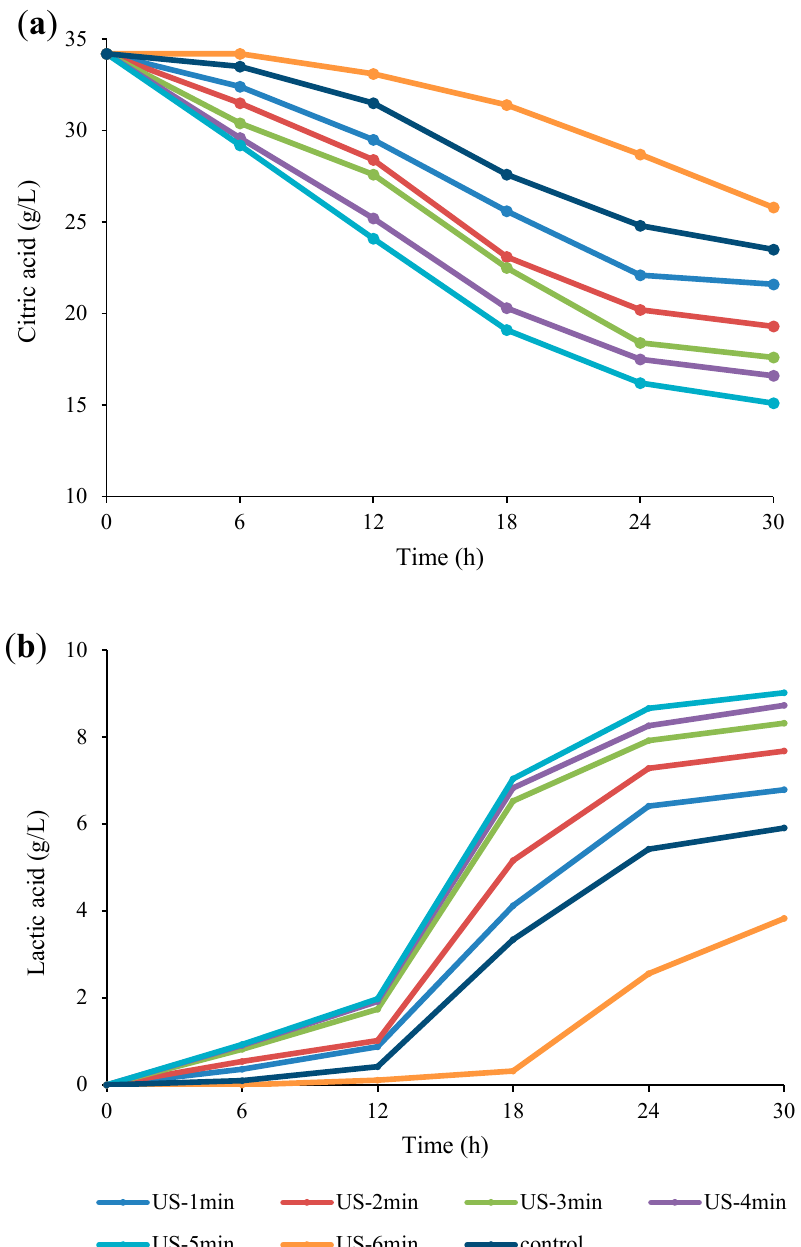
Figure 3. Changes in the amount of citric acid ( a ) and lactic acid ( b ) in US-treated and non-US treated Bakraei juice during fermentation. Error bars reveal the standard deviation of each measurement in Bakraei juice during 30 h of fermentation. US-1 min: ultrasound treatment for 1 min, Control: non-ultrasound treated juice.